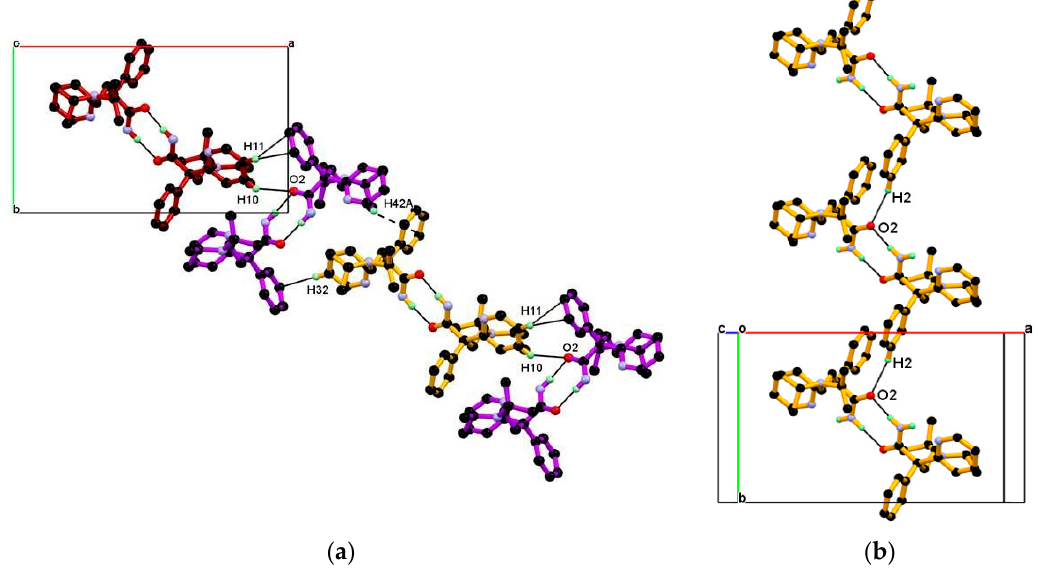
Figure 4. ( a ) Packing view of the dimeric unit down the c -axis, resulting in a 1-D chain of dimeric unit containing an alternate arrangement of vertically and horizontally oriented dimeric unit along the ab -diagonal; they are associated through alternate C10-H10 ∙∙∙ O2, C11-H11 ∙∙∙ C g 4, and C32-H32 ∙∙∙ C g 2, C42-H42A ∙∙∙ C g 4 interaction and ( b ) Packing of dimeric unit along the b -axis resulting in a helical chain of the dimeric unit, linked through C2-H2 ∙∙∙ O2 interaction.